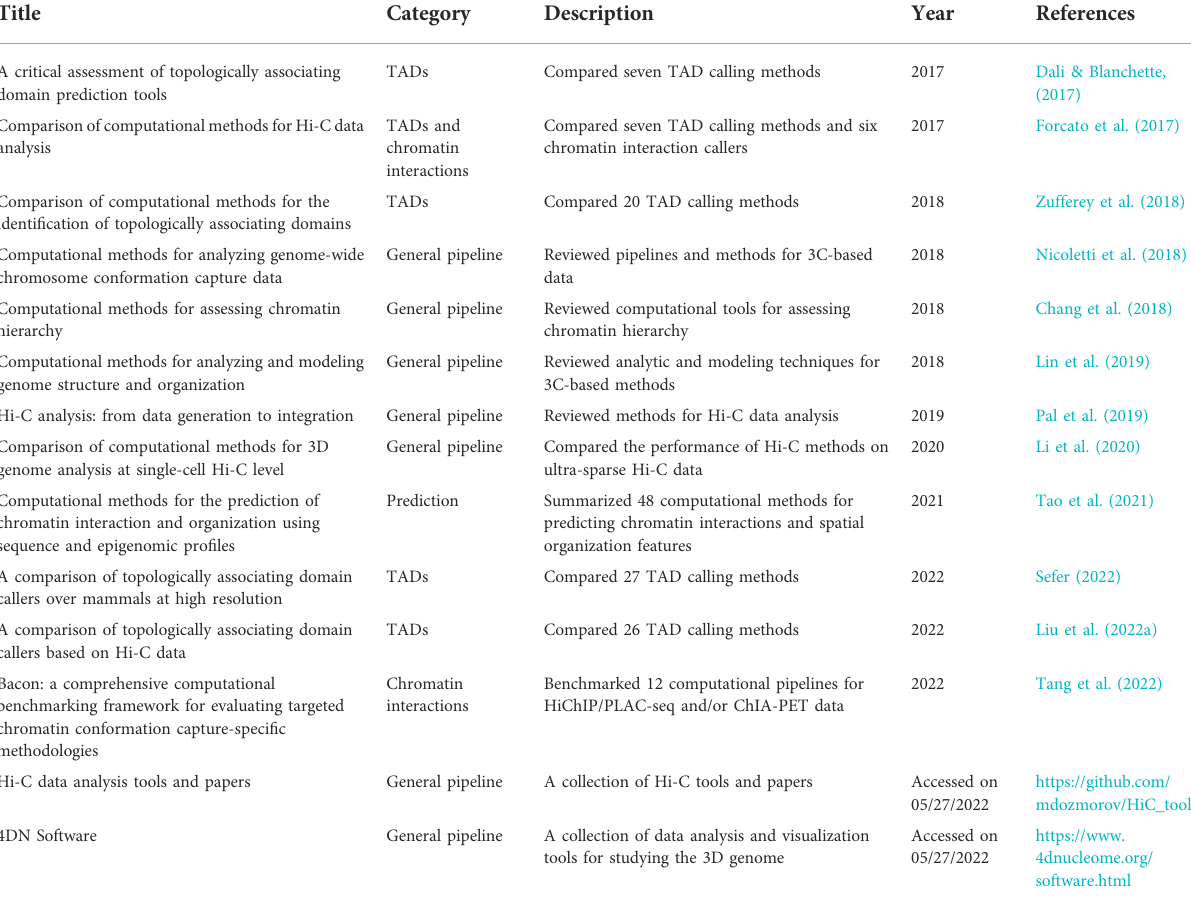
TABLE 1 Review papers and collections of computational approaches for chromatin interactions and